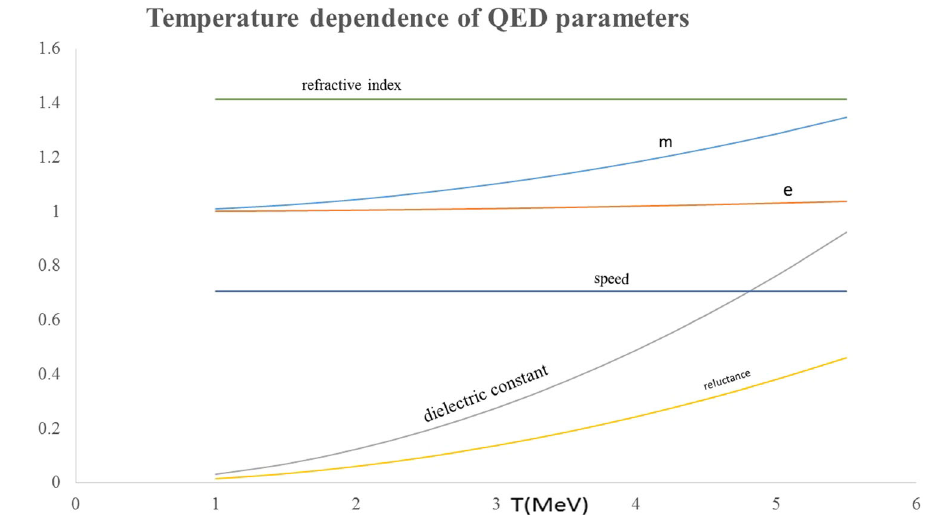
Fig. 5 All of the plasma parameters are plotted as functions of temperature such that the reluctance, propagation speed, and dielectric constant all increase with temperature